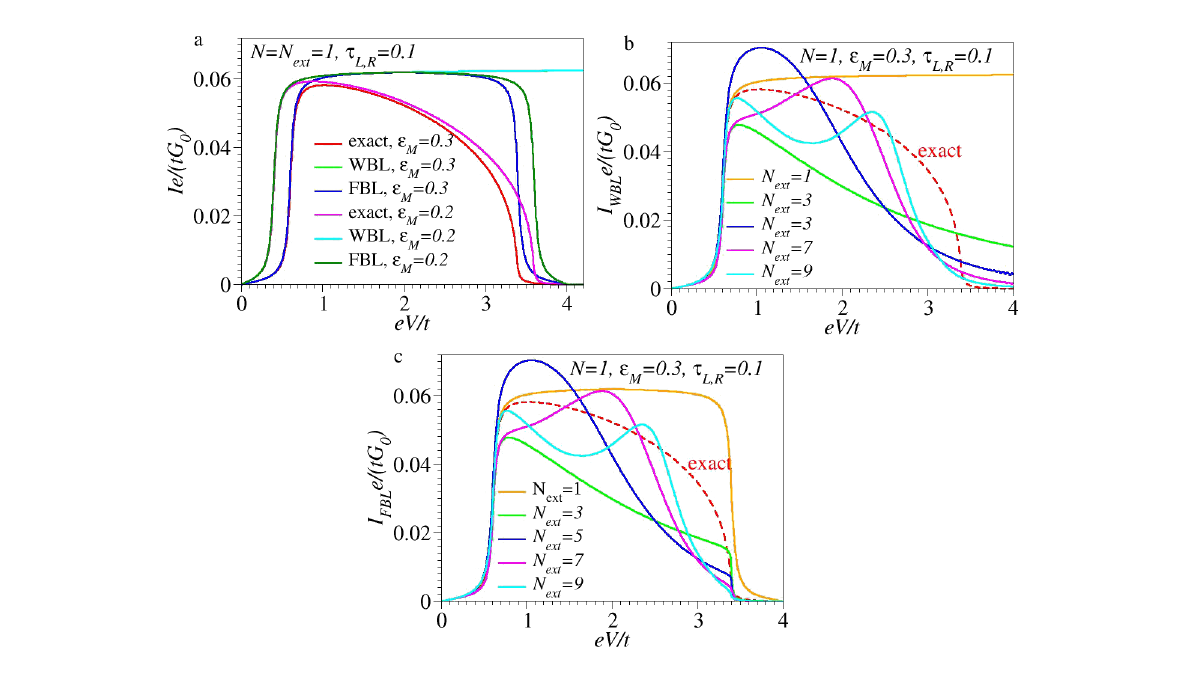
Figure 2: Dimensionless I – V curves computed for a small molecule consisting of a single site/level ( N = 1) of energy ε M . (a) Exact results along with those obtained within the WBL and FBL, considering an extended molecule identical to the small molecule ( N = N ext = 1). (b,c) Exact results along with those obtained within the WBL (panel b) and FBL (panel c) using an extended molecule containing a number of sites N ext = 1, 3, 5, 7, and 9. This mimics realistic calculations wherein up to four adjacent layers from electrodes are added to the small molecule. The energy unit is t = t L,R = 1, and the other model parameters are given in the inset.